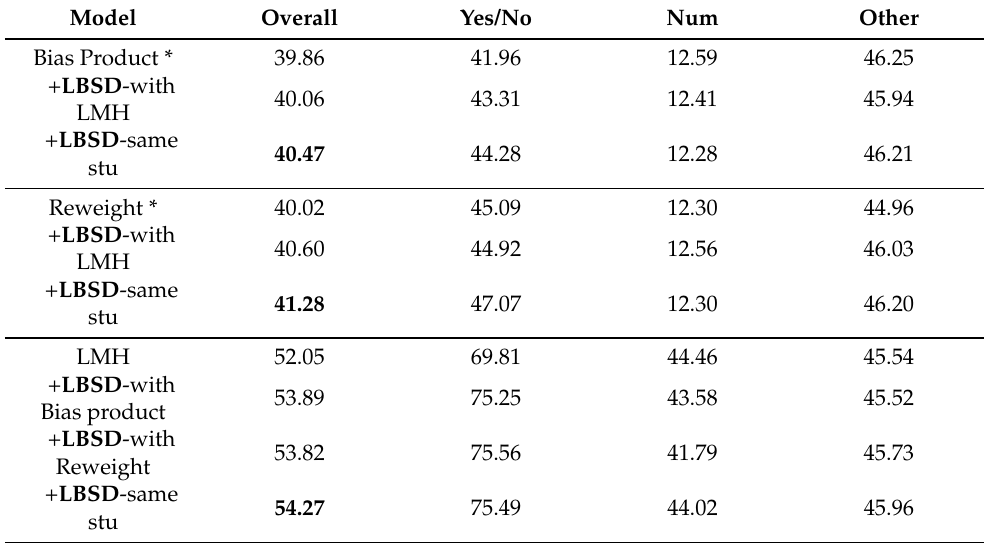
Table 5. VQA-CP v2: Heterogeneous student networks. * indicates the results from our reimplemen- tation using officially released